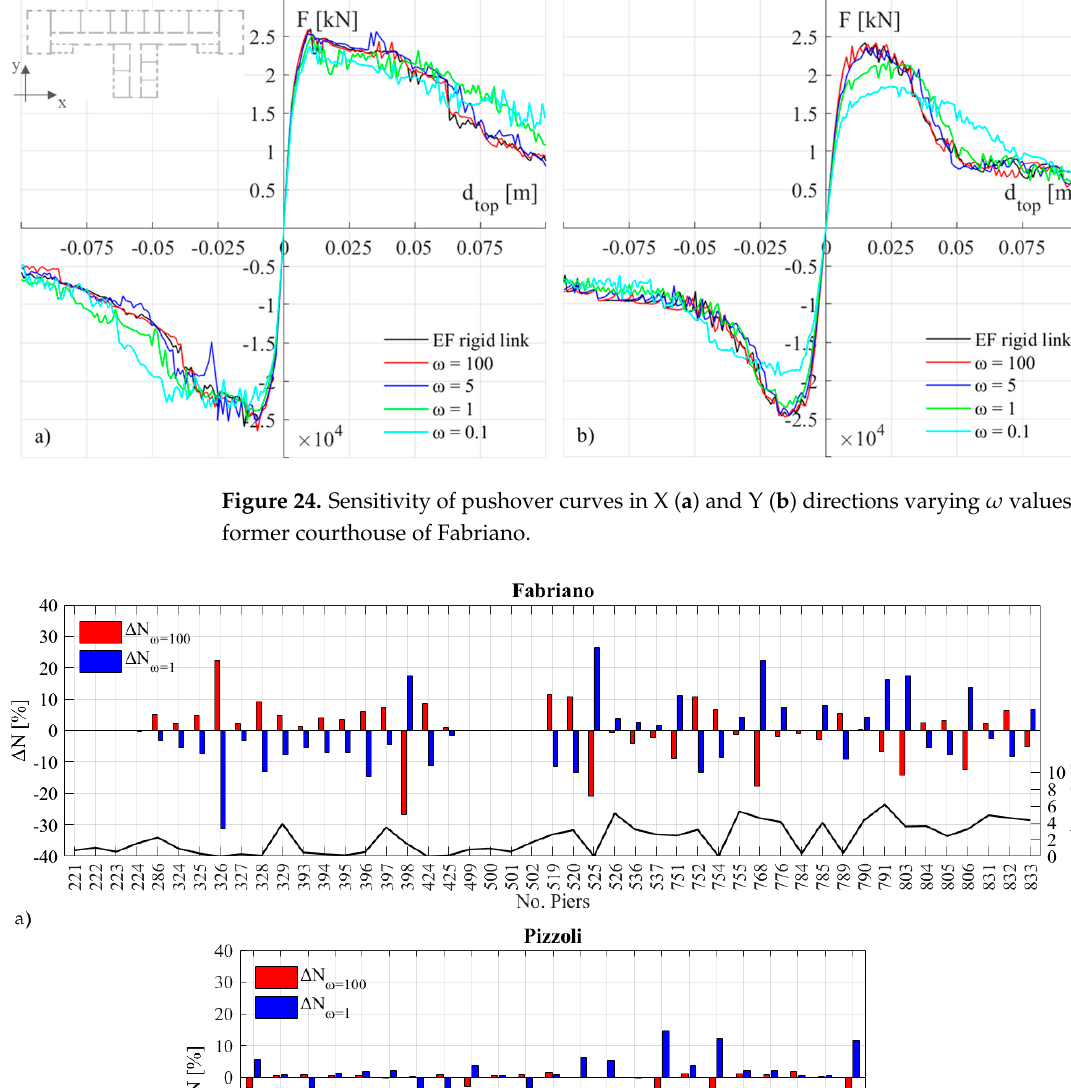
Figure 23. Sensitivity of pushover curves in X ( a ) and Y ( b ) directions varying ω values in the case of Pizzoli’s town hall.